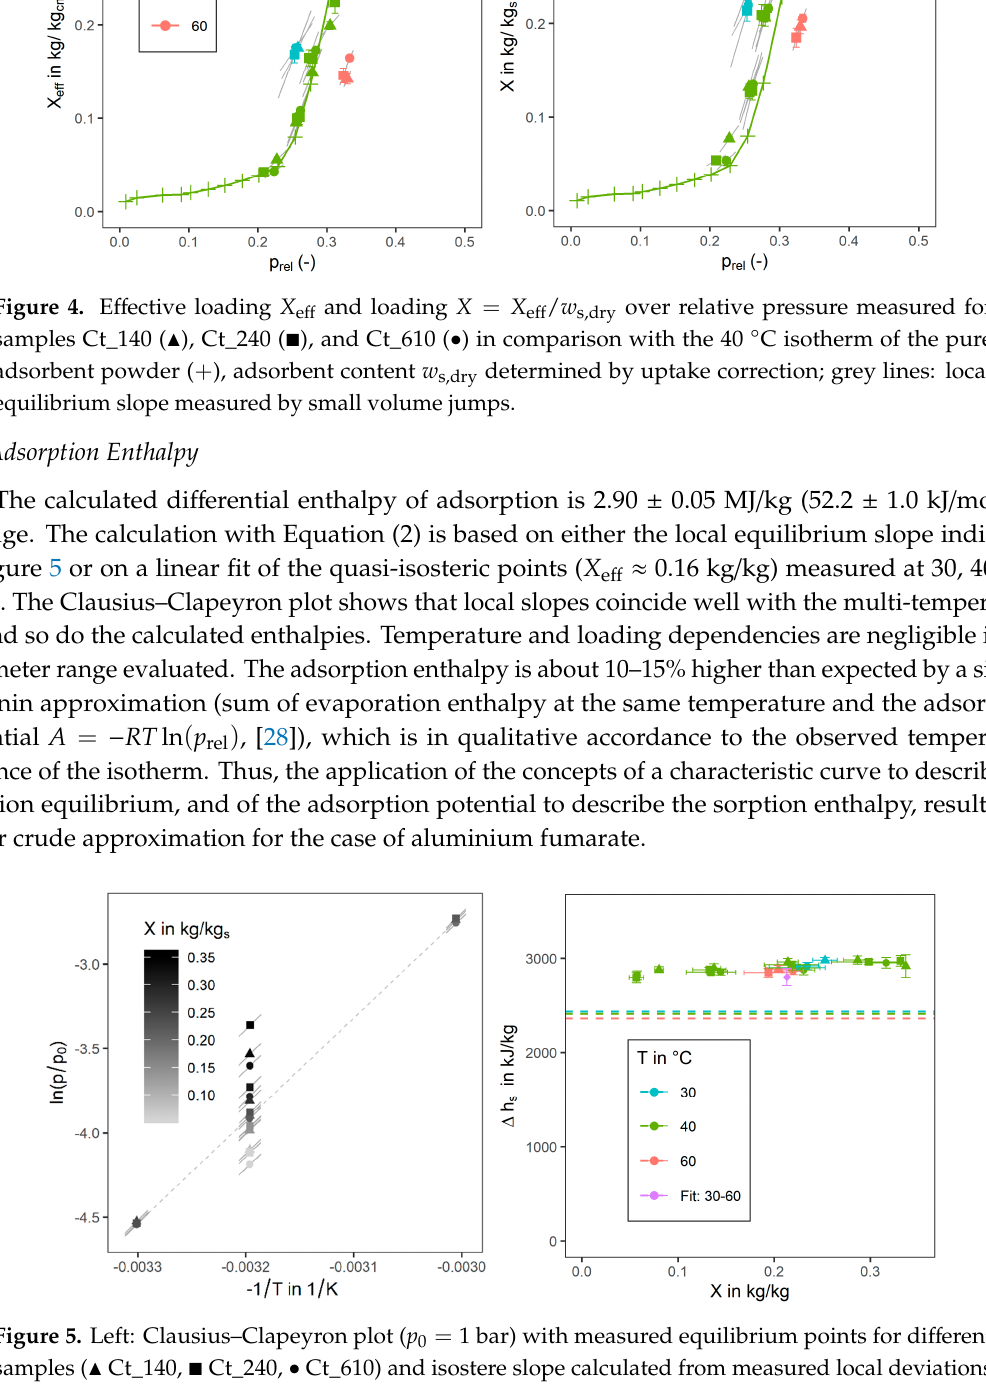
Figure 5. Left: Clausius–Clapeyron plot ( 𝑝 (cid:2868) = 1 bar) with measured equilibrium points for different samples ( (cid:78) Ct_140, (cid:4) Ct_240, • Ct_610) and isostere slope calculated from measured local deviations samples ( ▲ Ct_140, ■ Ct_240, ● Ct_610) and isostere slope calculated from measured local deviations (short grey lines) and linear fit of points with X e ff ≈ 0.16 kg / kg (- - -), uncertainties of T and p are bellow (short grey lines) and linear fit of points with 𝑋 (cid:2915)(cid:2916)(cid:2916) ≈ 0.16 kg/kg (- - -), uncertainties of 𝑇 and 𝑝 are bellow point size; Right: differential adsorption enthalpy calculated from isostere slopes of local point size; Right: di ff erential adsorption enthalpy calculated from isostere slopes of local equilibria and equilibria and 0.2-kg/kg-fit over corrected loading with the evaporation enthalpy of water (- - -) 0.2-kg / kg-fit over corrected loading with the evaporation enthalpy of water (- -